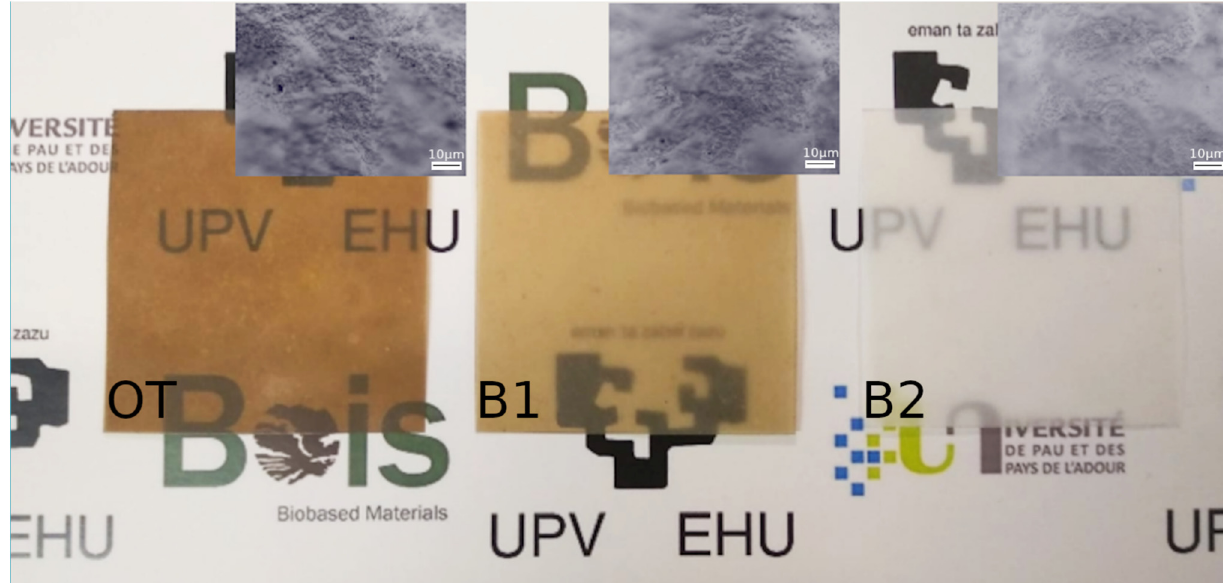
Figure 5. Visual aspect and micrographs of the elaborated